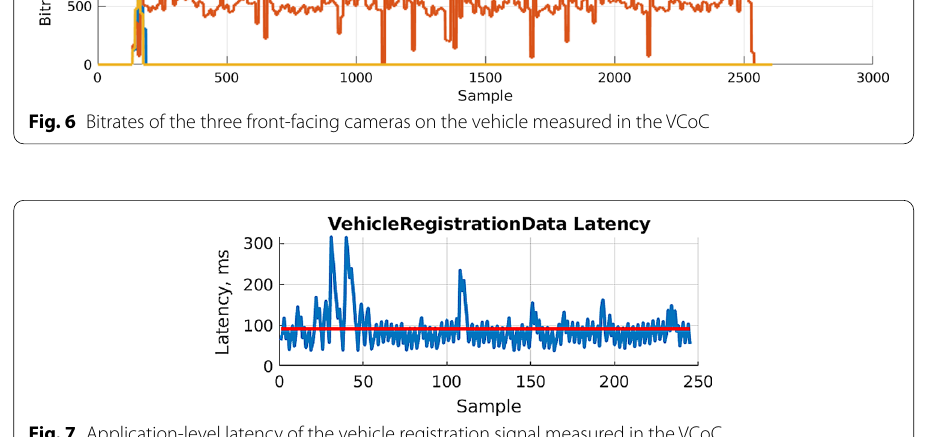
possible to follow them completely. In particular, the fully required steering wheel angle is not achieved.